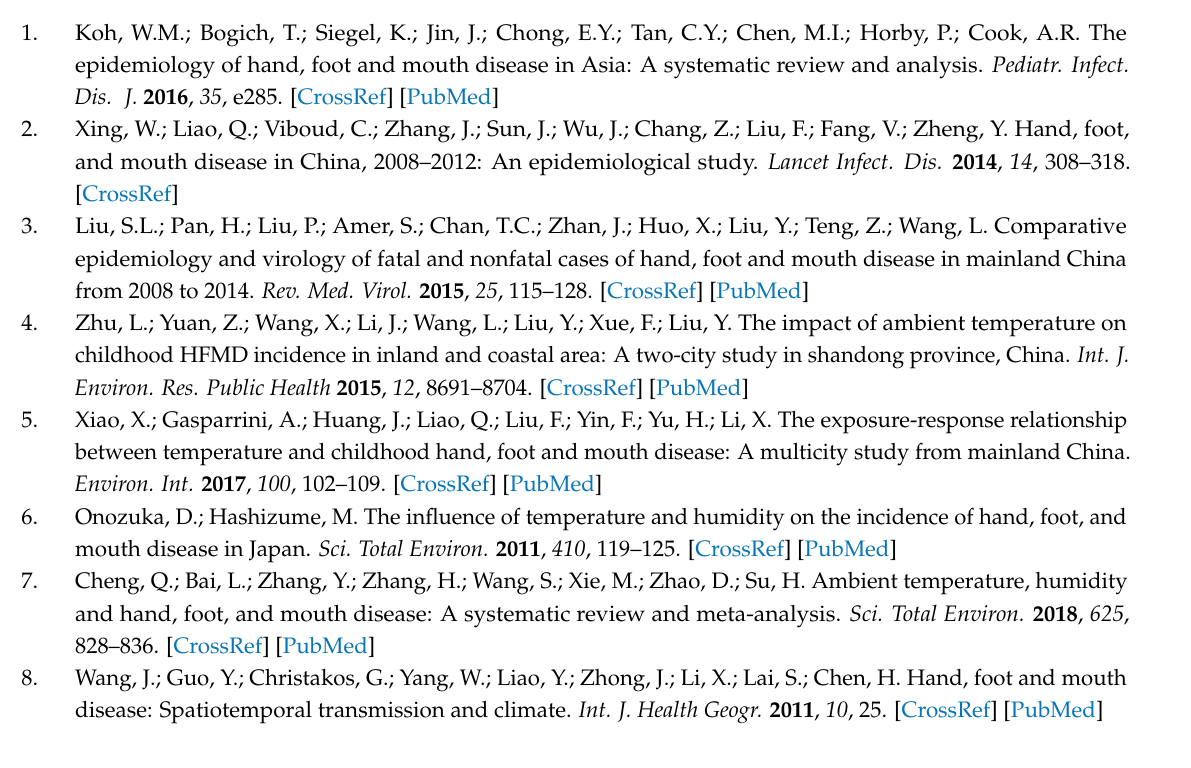
s1, File 1: Climate and socioeconomic variables (Table S1: Index of climate and socioeconomic variables.), File 2: Modeling R codes, File 3: Covariates selection results (Table S2: Results of multicollinearity evaluation, Table S3: Results of the forward stepwise regression, Table S4: DIC evaluation.), File 4: Spatial cluster mapping (Moran’s I